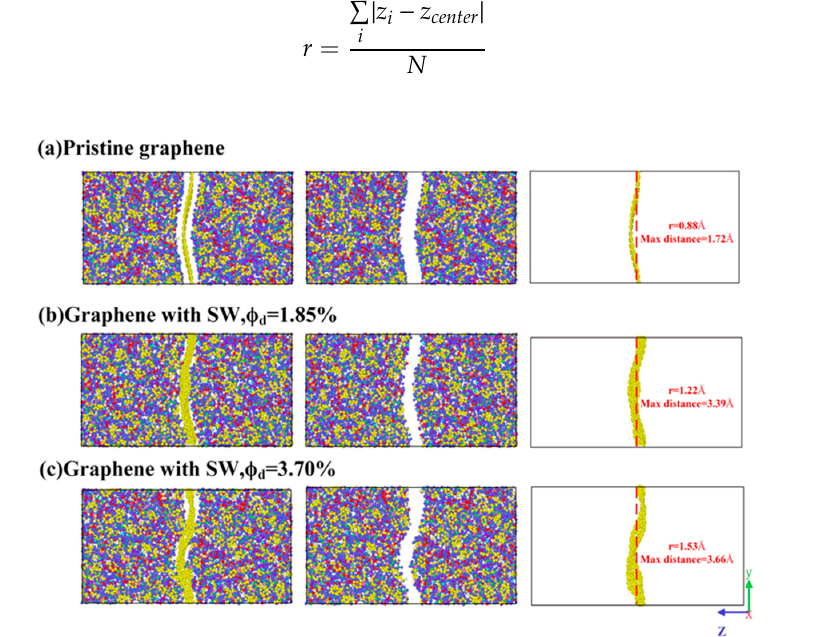
Figure 8. The molecular models of graphene, epoxy and nanocomposite with different concentrations of SW defect.